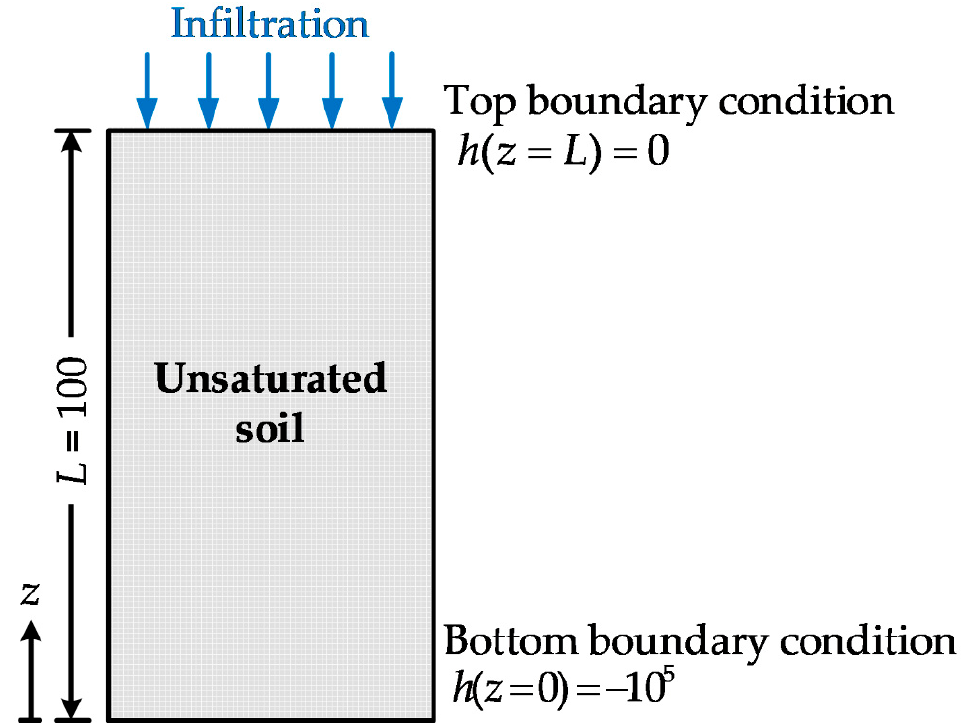
Figure 4. Schematic illustration of one-dimensional steady-state infiltration problem.